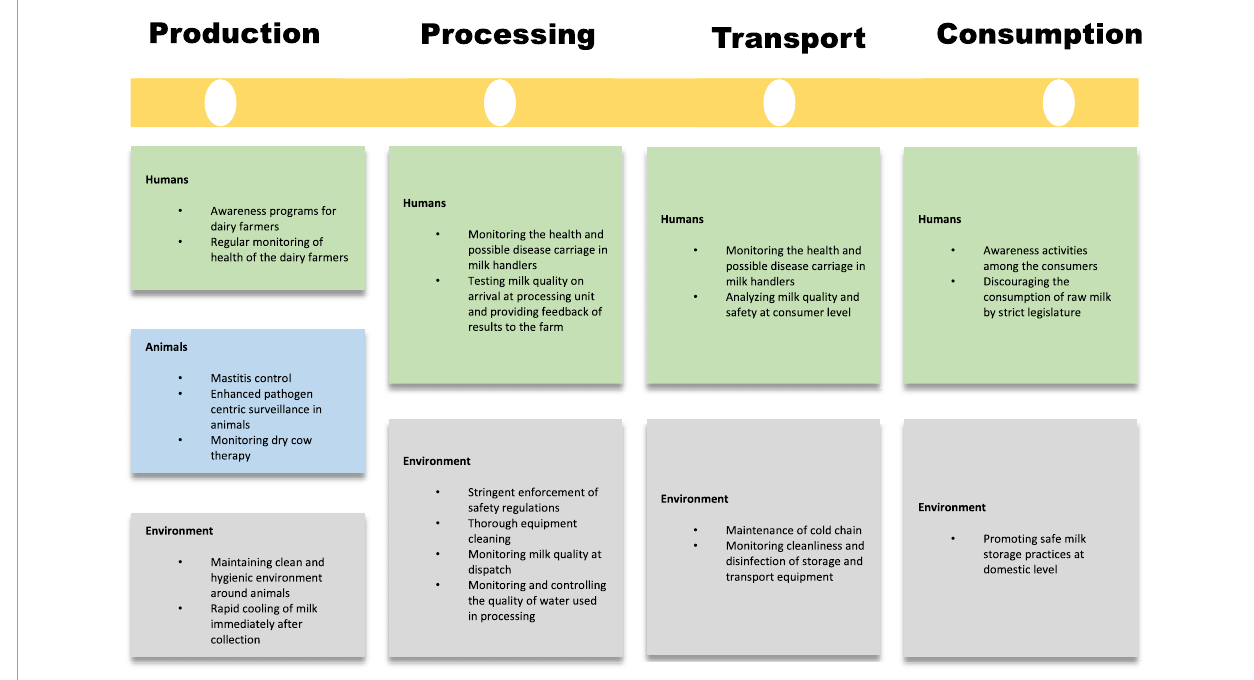
FIGURE2 Four checkpoint approach to combat milk borne diseases at the level of production, processing, transport, and consumption.